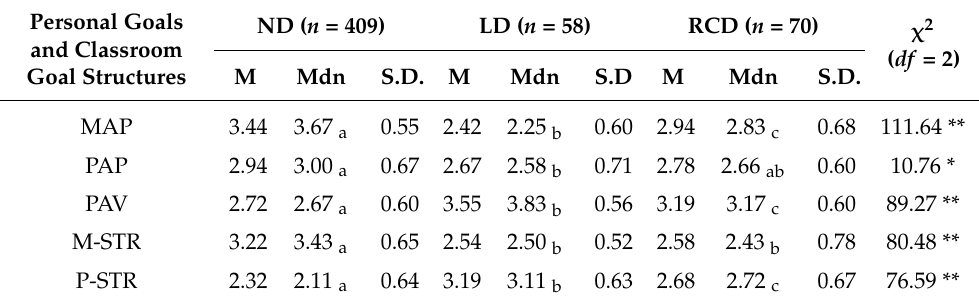
Table 1. Mean scores, median scores, and standard deviations for the study variables.